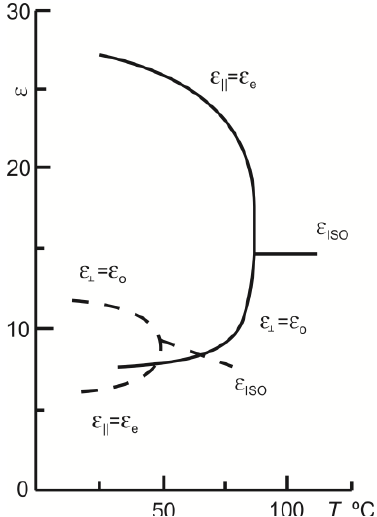
Figure 1. Typical behavior of the real permittivity temperature dependence for two nematic liquid crystals (LCs) with positive (solid line) and negative (dashed line) permittivities [13]. With kind permission from Springer Science+Business Media